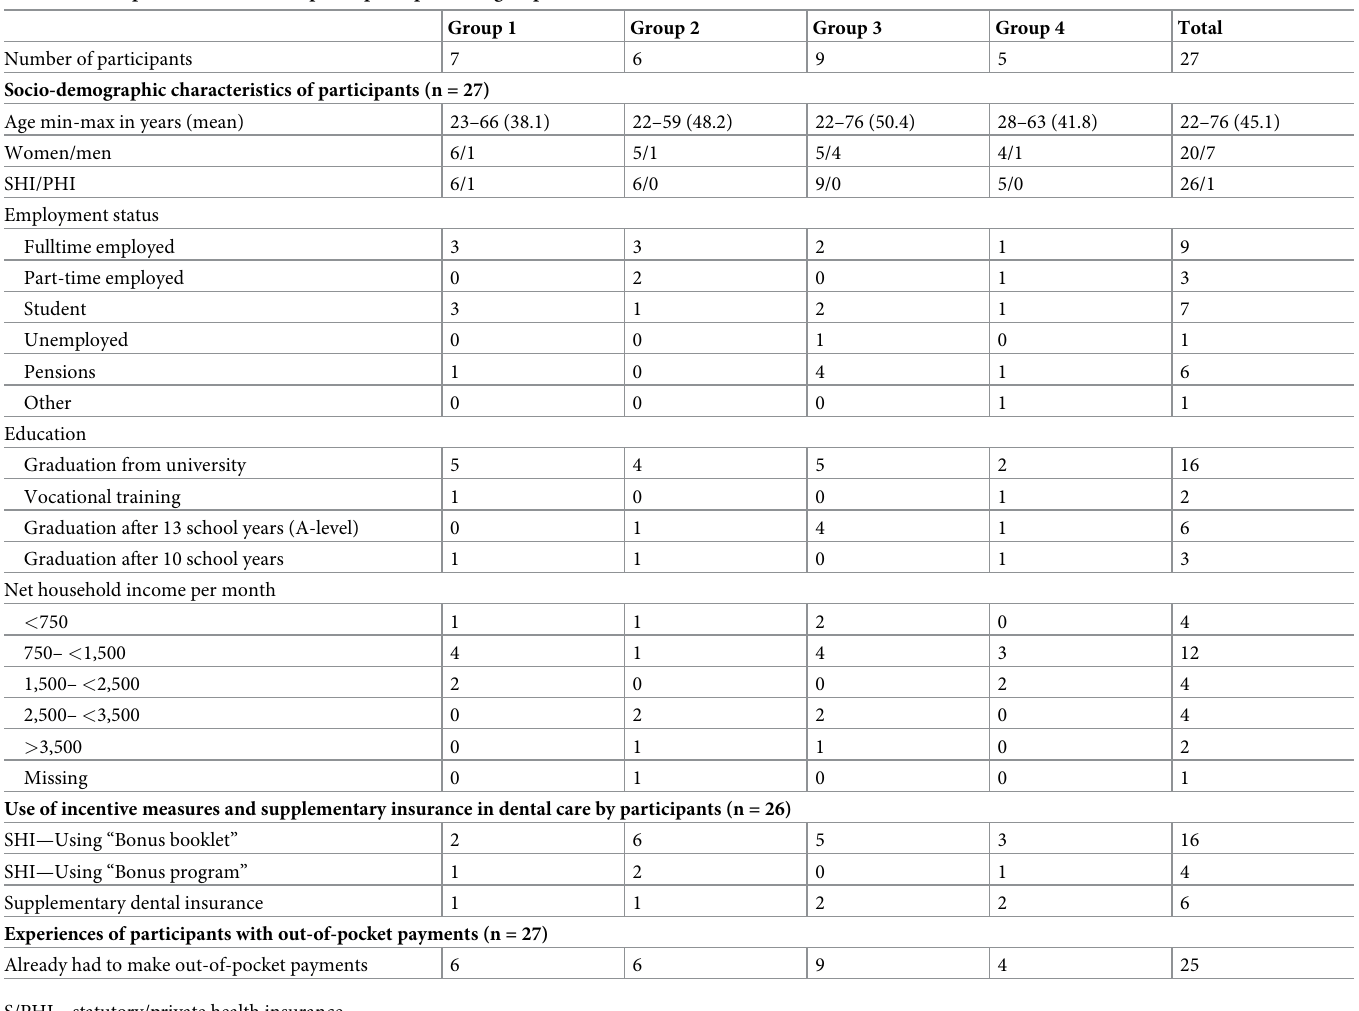
Table 1. Descriptive information on participants per focus group and in